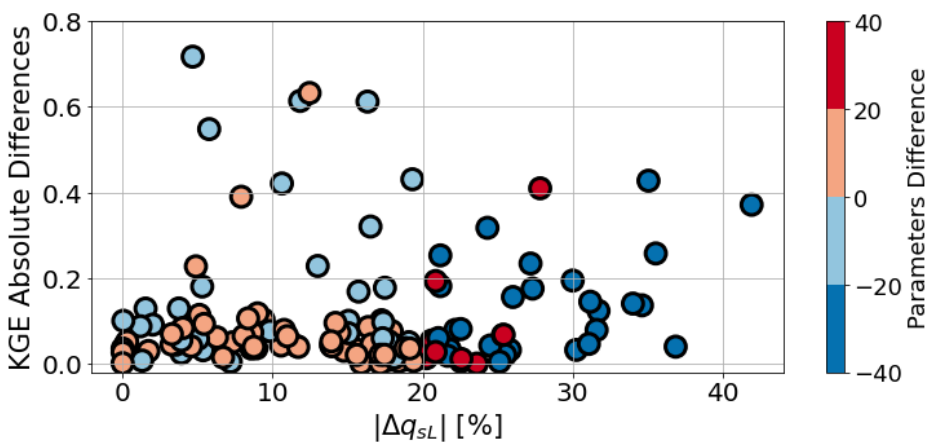
Figure 14. Parameters’ absolute differences vs. KGE differences at the USGS gauges. The colors